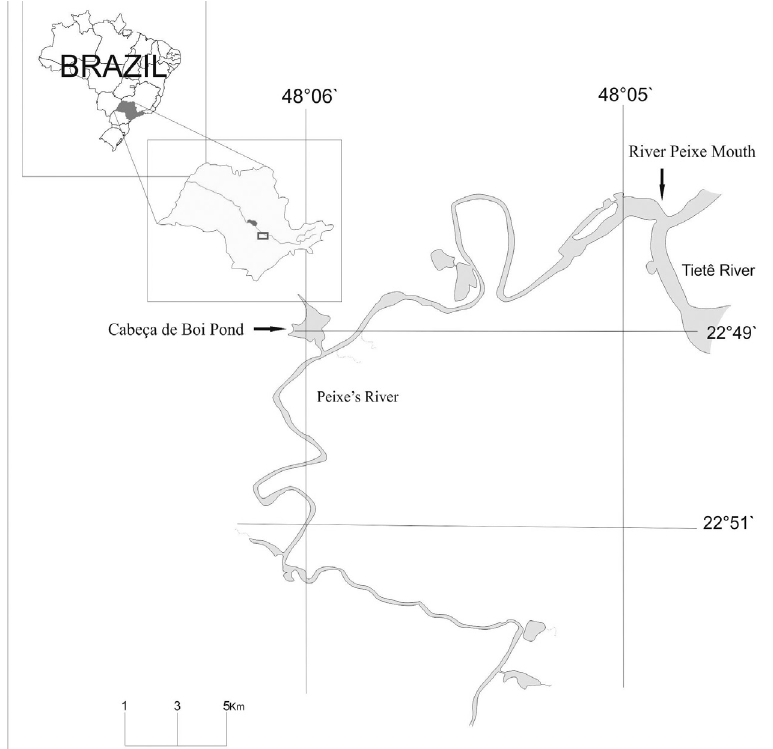
Figure 1 - Map of study area, showing details of river and their geographic